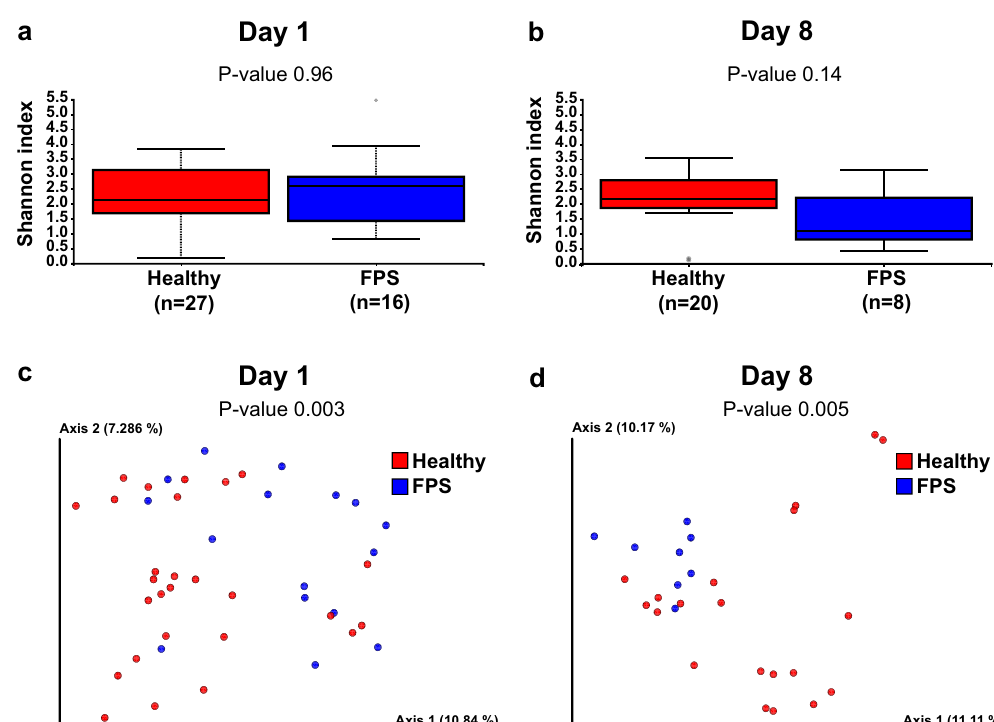
Fig. 6 Rectal bacterial alpha and beta diversity in Days 1 and 8 post-partum samples from healthy puppies and those that sustained FPS later on. a , b alpha diversity analysis using Shannon index: the rectal microbial alpha diversity on Days a 1 and b 8 post-partum did not differ between healthy puppies and those that later sustained FPS (and died) using the Wilcoxon sum-rank test, P = 0.96 and P = 0.14, respectively). c , d principal coordinate analysis plots demonstrating beta diversity of healthy puppies (red) and those that sustained FPS later on (blue), which revealed signi fi cantly different rectal bacterial community composition in puppies that later sustained FPS compared to healthy puppies, both on c Day 1 (permutational multivariate analysis of variance, P = 0.003) and d Day 8 (permutational multivariate analysis of variance, P = 0.005) PP.